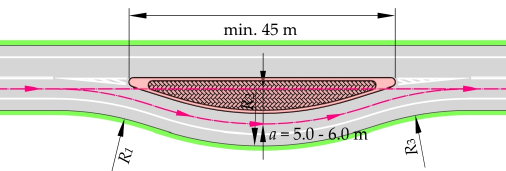
Figure 22. Semi-circular chicane horizontally deflecting one lane proposed for village transition zones approached through a patch of forest (based on the guidelines [21,24,25]).